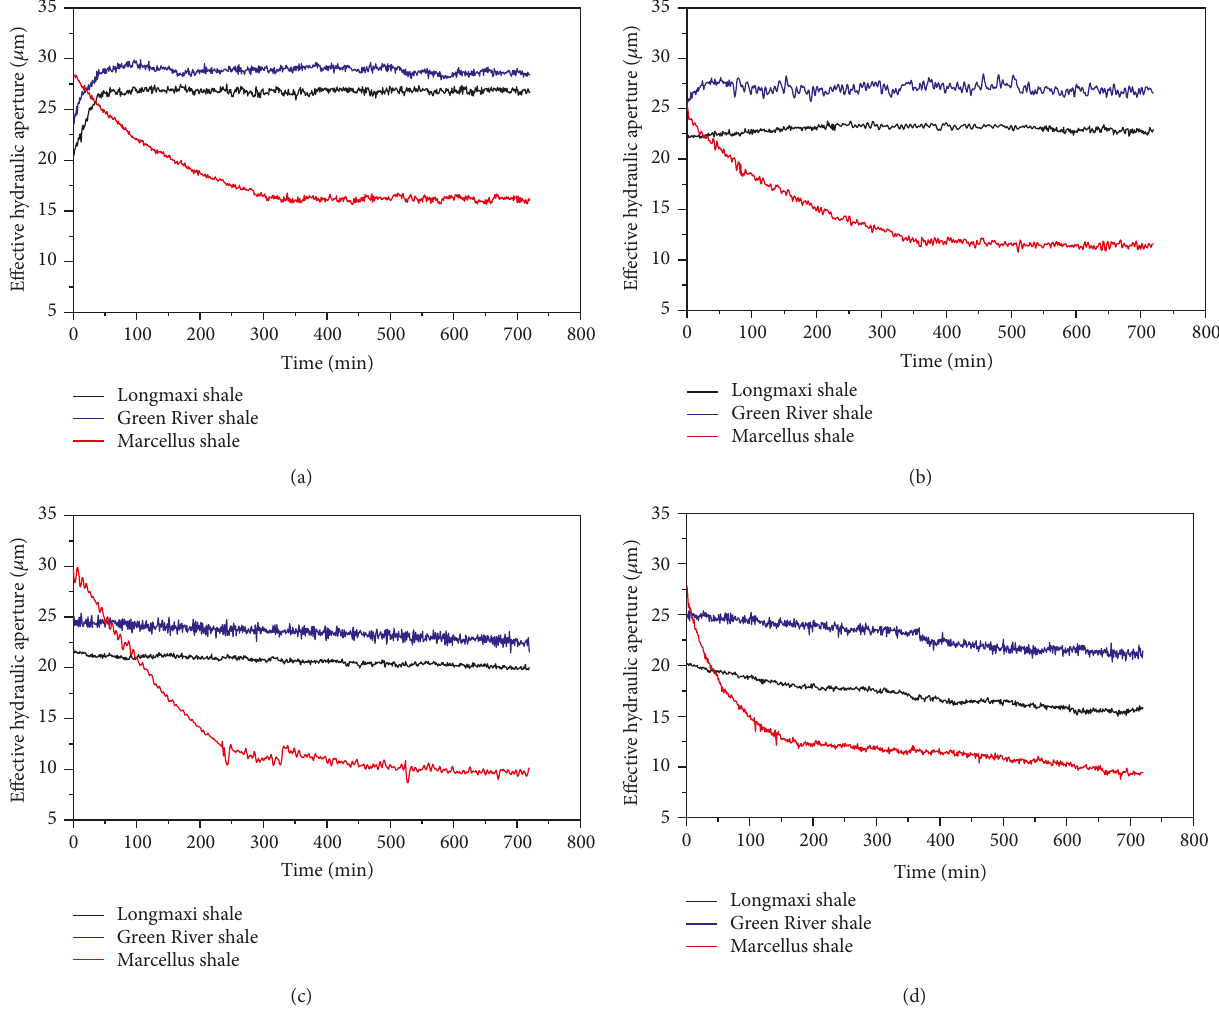
Figure 6: Aperture evolutions with time for various shale. (a) Fluid pH =4.0, (b) fl uid pH =5.0, (c) fl uid pH=6.0, and (d) fl uid pH=7.0. For shale with di ff erent mineralogical composition, aperture evolution shows distinct trend. Higher acidic fl uid increases the aperture for Longmaxi shale and Green River shale while lower acidic fl uid close fractures for all three kinds of shale.